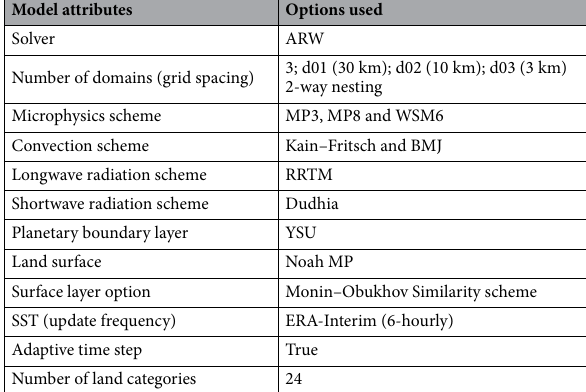
Table 1. List of WRF options used in this